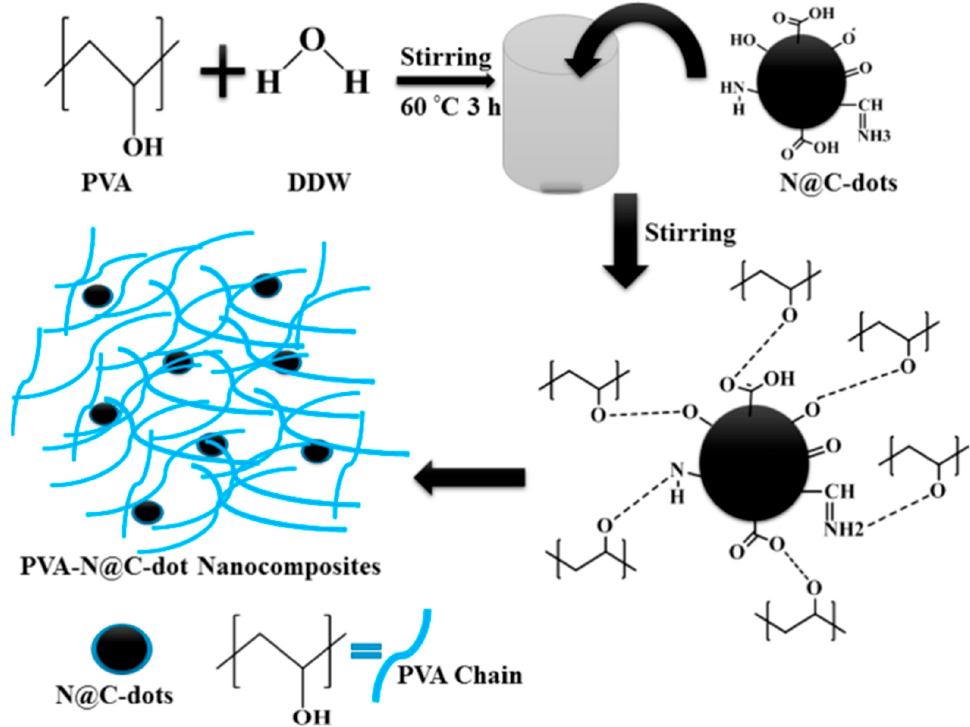
Figure 6. Illustration of the preparation of PVA-N@CDs composites and the appropriate H-bonding interaction between N@CDs and PVA leading to PVA chains’ cross-linking to form the PVA-N@CDs film. Reprinted with permission from [74]. Copyright (2017) American Chemical Society.